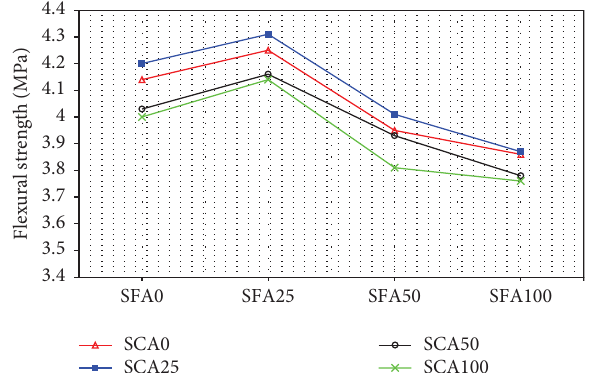
Figure 8: Flexural strength of concrete specimens containing diferent amount of serpentine